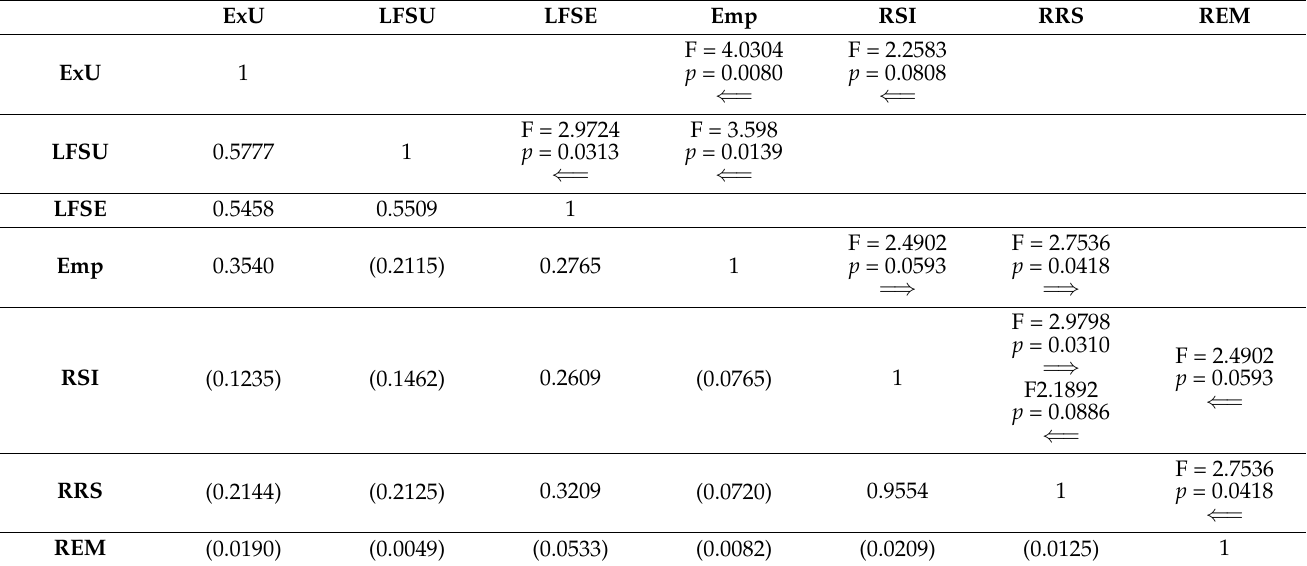
Table 2. Coherence and causality at frequency ω =